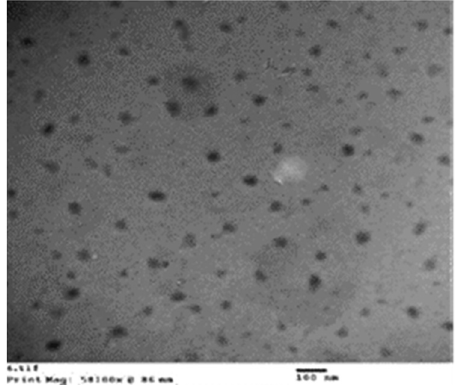
Figure 1: Transmission electron micrographs ( TEMs ) of glutathione - loaded niosomes, N - GSH ( formulation, GTN - 8 )